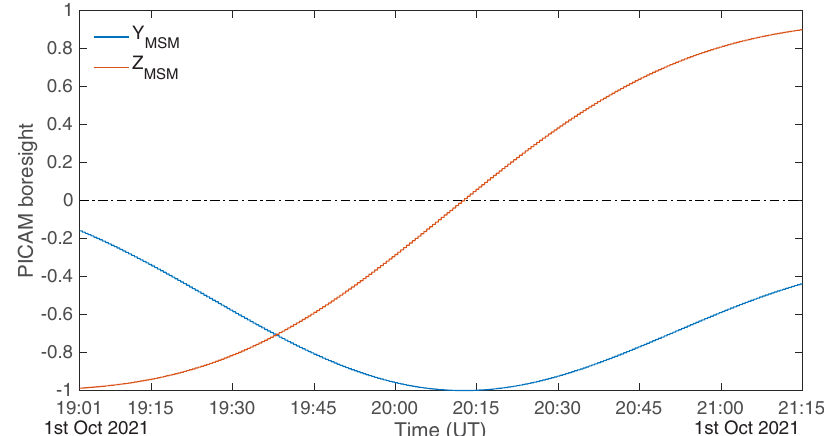
Fig.3|PICAMboresightcomponentsalongYMSMandZMSMversusUTduring MFB1. TheY MSM andZ MSM componentsofthePICAMboresightareploottedversus UT for the time interval from 19:00 UT to 21:15 UT of the 1st of October, 2021. The